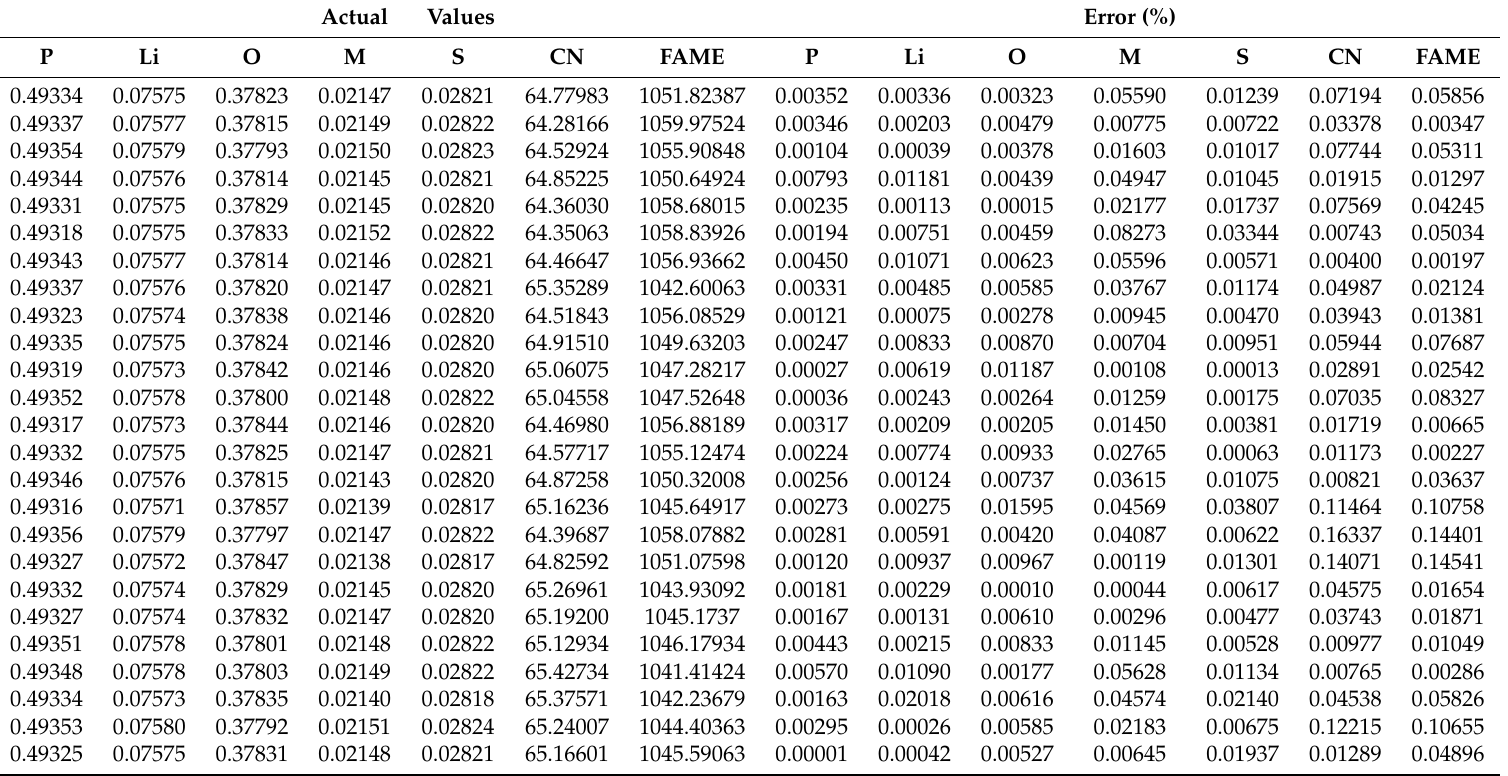
Table 4. Actual values of target outcomes of soft sensors and errors exhibited during their